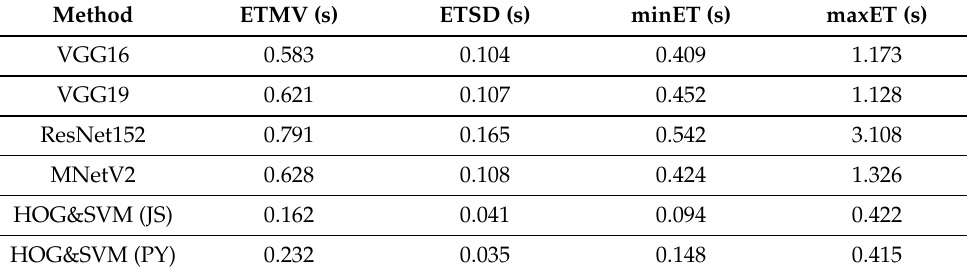
Table 8. Temporal results of the tests performed on the tactode_big test